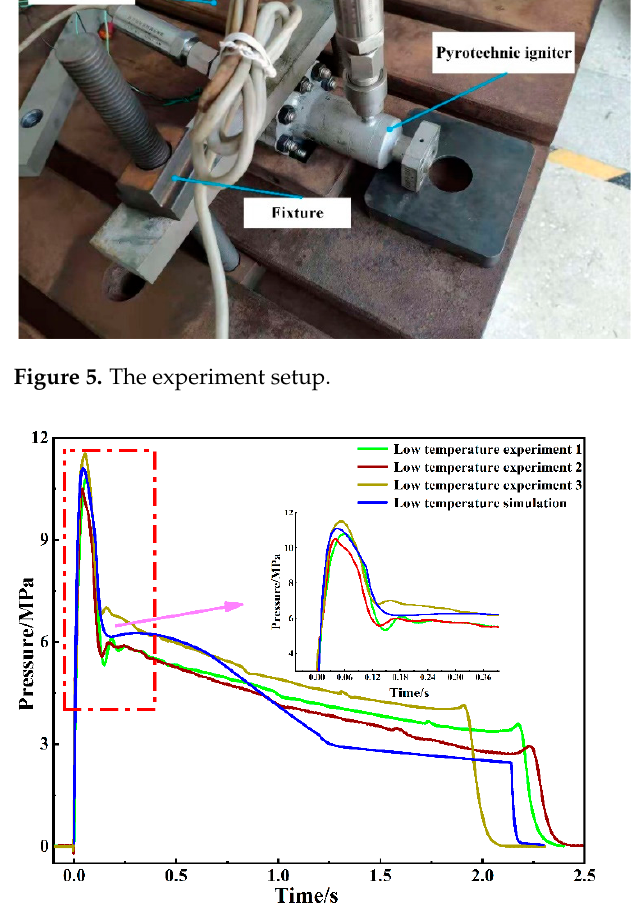
Figure 6. Comparison between the simulation model and the experiment results. Table 2. Comparison between the Simulation model and the experiment characteristic parameters. Parameter